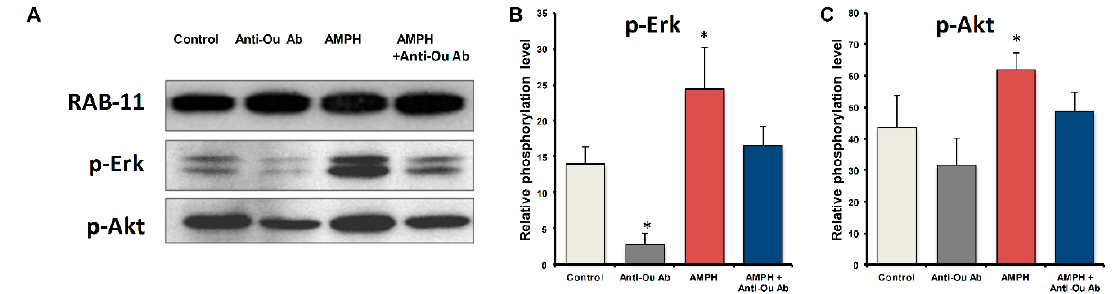
Figure 1. Effect of amphetamine and anti-ouabain antibodies on ERK and Akt phosphorylation levels in the frontal cortex. Male BALB/c mice were administered saline (10 mL/kg IP) and nonspecific IgG (1 µg/kg ICV) (Control, n = 10), saline and anti-ouabain antibodies (1 µg/kg i.c.v.) (Anti-Ou Ab, n = 10) or AMPH (5 mg/kg IP) and IgG (AMPH, n = 10) or AMPH and anti-ouabain antibodies (AMPH + Anti-Ou Ab, n = 10). The mice were sacrificed and the protein levels were determined by Western blot analysis. The values are presented as the mean ± SE (error bars). * p < 0.05. (This figure was adapted with permission from Hodes A, Rosen H, Deutsch J, Lifschytz T, Einat H., and Lichtstein D. Endogenous cardiac steroids in animal models of mania. Bipolar Disorder. 2016 Aug; 18(5):451–9).